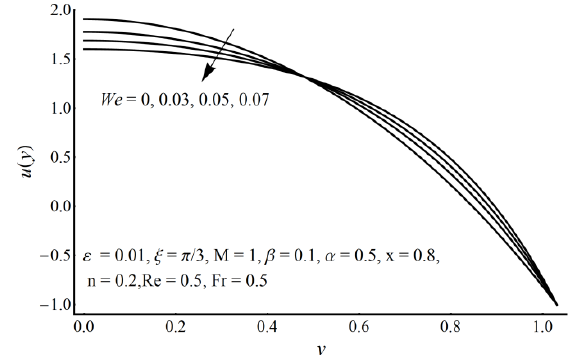
Figure 2. The velocity profile for different values of variable We.